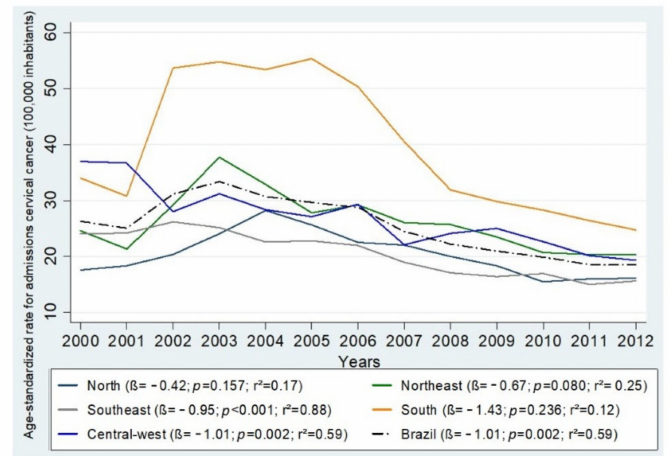
Figure 3. Incidence of hospital admissions for cervical cancer (100,000 inhabitants), resident in Brazil aged 25–64 years, in the period from 2000 to 2012 and estimates obtained from linear regression, according to year and regions.